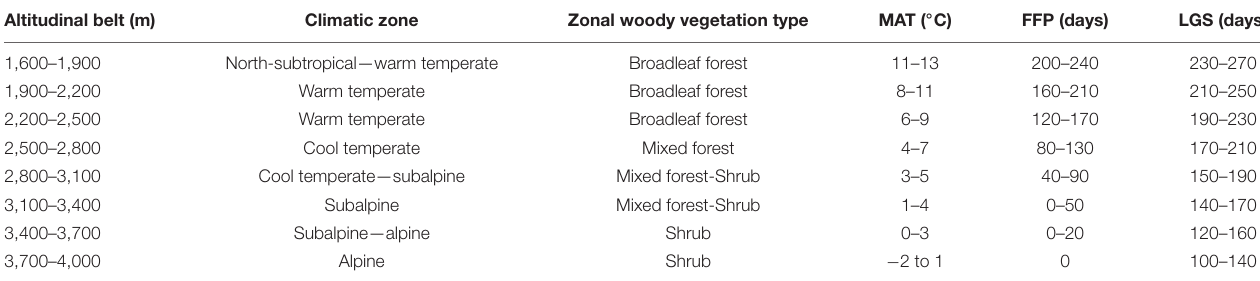
TABLE 1 | A comparison of climate and vegetation characteristics of each 300-m altitudinal belt. Altitudinal belt